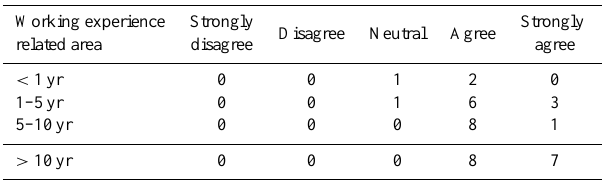
Table 7. Usefulness of knowledge gained for professional work by years of working experience ( n = 37).